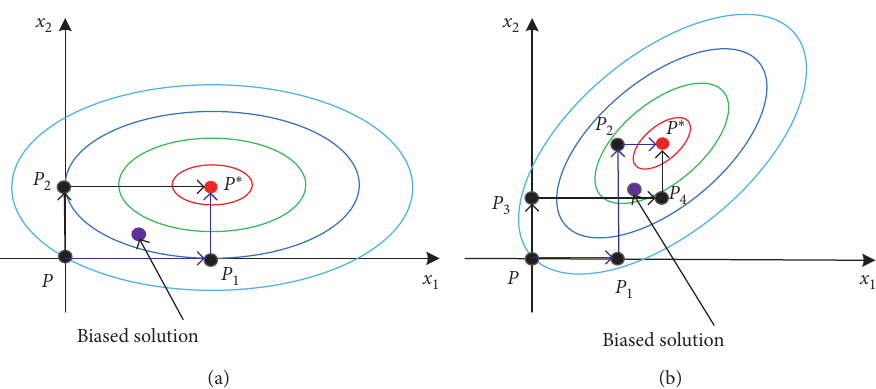
Figure 2: The search process of the solution P by learning the biased information for the quadratic function (a) and the rotated quadratic function (b), respectively.